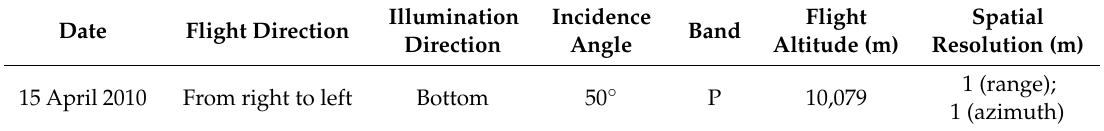
Table 1. Information about the PolSAR data used in this